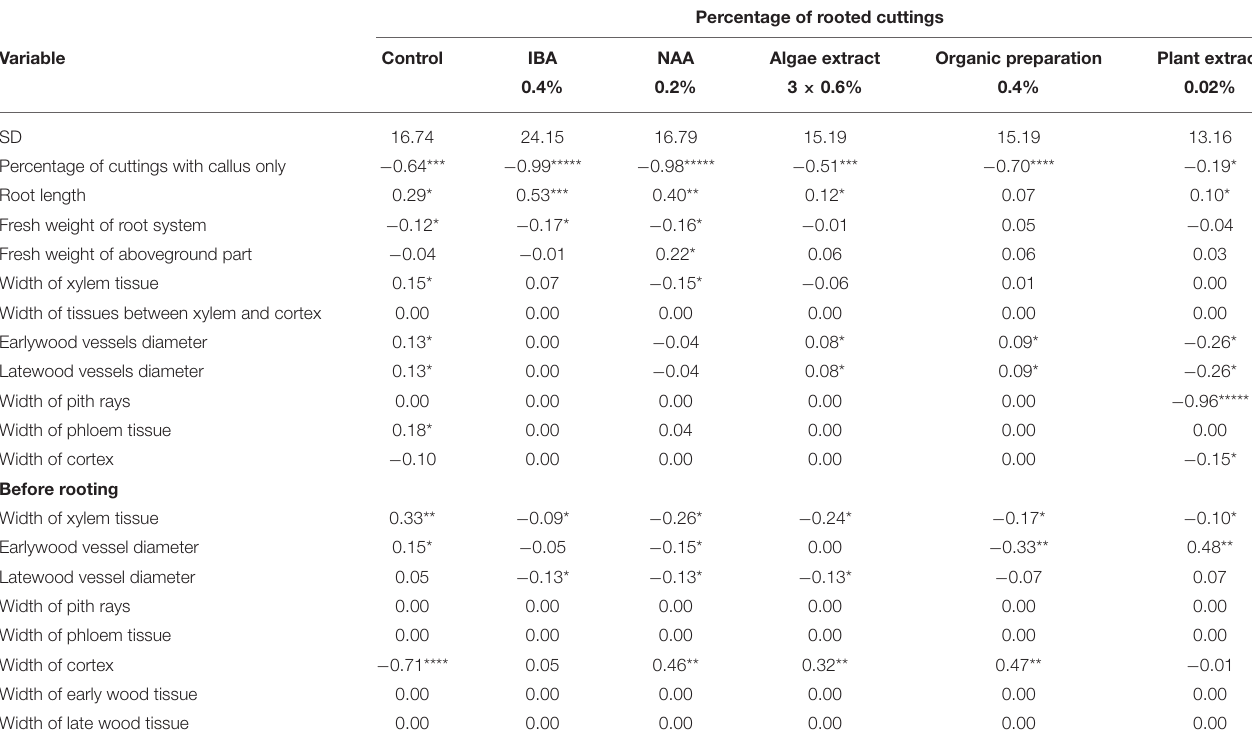
TABLE 5 | Effect correlations between percentage of rooted cuttings and measured parameters of growth and anatomical structure in Rosa “Hurdal” before and after 25 days of rooting cuttings derived from shoots H3, immediately after petals have fallen (BBCH 69